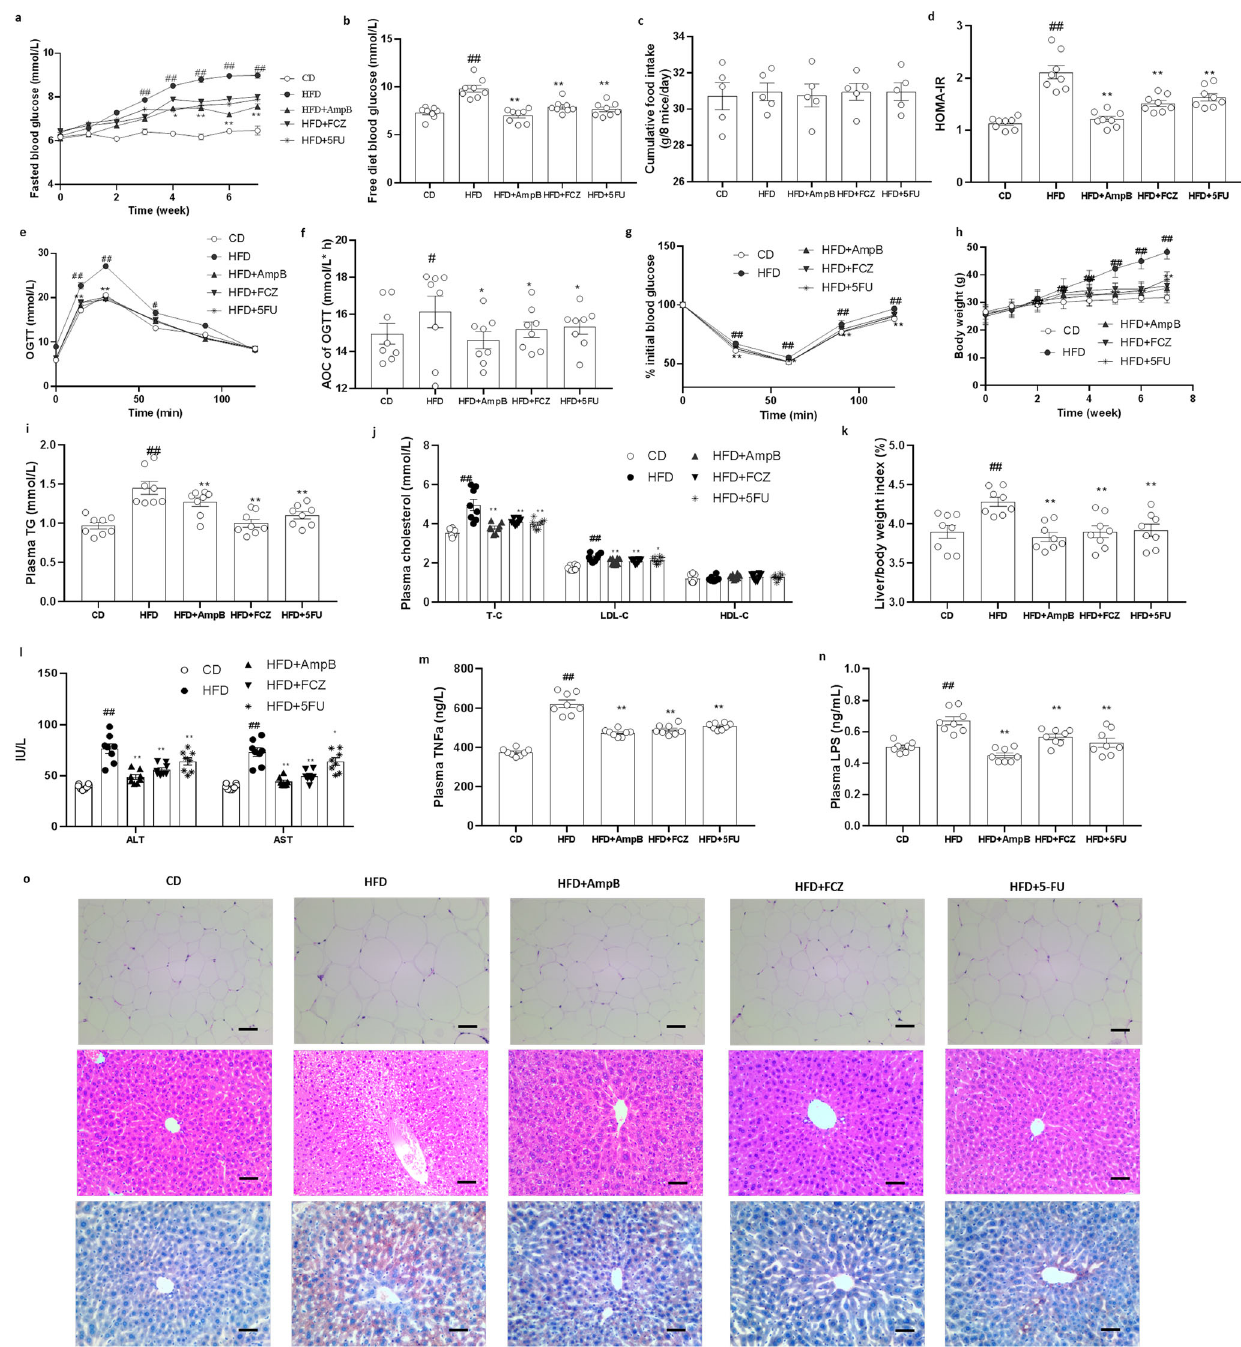
Fig. 1 Antifungal agents treatment alleviated glucose metabolism related disorders in HFD-fed mice. a Fasted blood glucose, b Free blood glucose